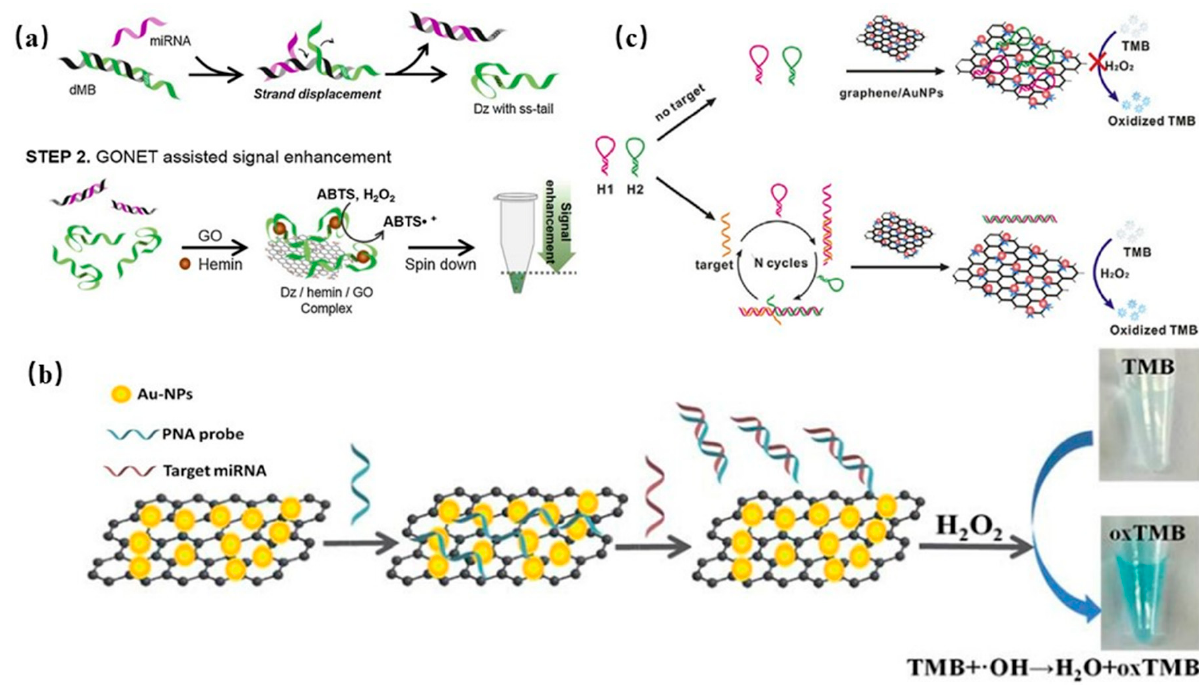
Figure 6. Colorimetric sensing DNA and RNA with 2D materials: ( a ) Colorimetric detection of graphene by miRNA network. Reprinted with permission from Ref. [68], Copyright 2019, Elsevier. ( b ) Graphene/AuNP hybrid material detection by miRNA. Reprinted with permission from Ref. [69], Copyright 2016, Royal Society of Chemistry. ( c ) Graphene/gold hybrid material detection by DNA. Reprinted with permission from Ref. [70], Copyright 2016,